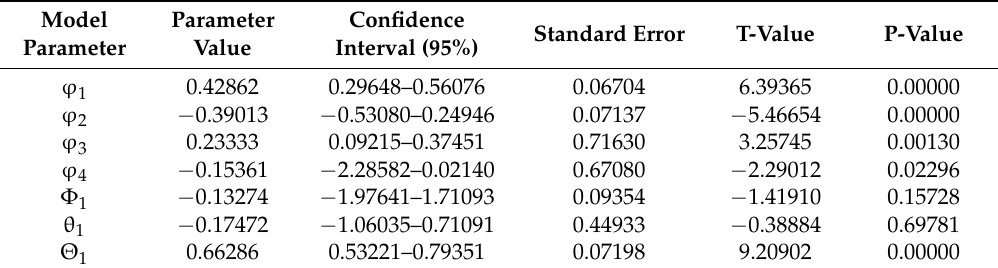
Table 4. Parameter value, Confidence interval (95%), Standard error, T-value and P-value for SARIMA model (4,1,1) (1,1,1) 12 of the logarithmic-transformed time series data of monthly discharge at Kefalovriso spring (1974–1993).